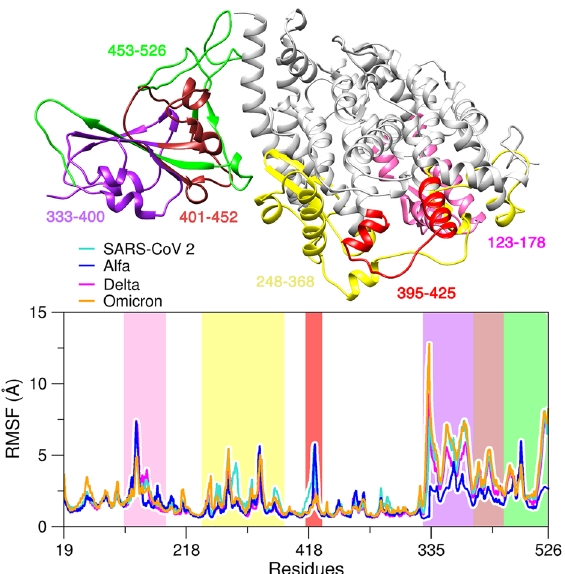
Figure 2. Three-dimensional structure of ACE2 and RBD with RMSF regions for SARS-CoV-2, Alpha, Delta and Omicron systems.